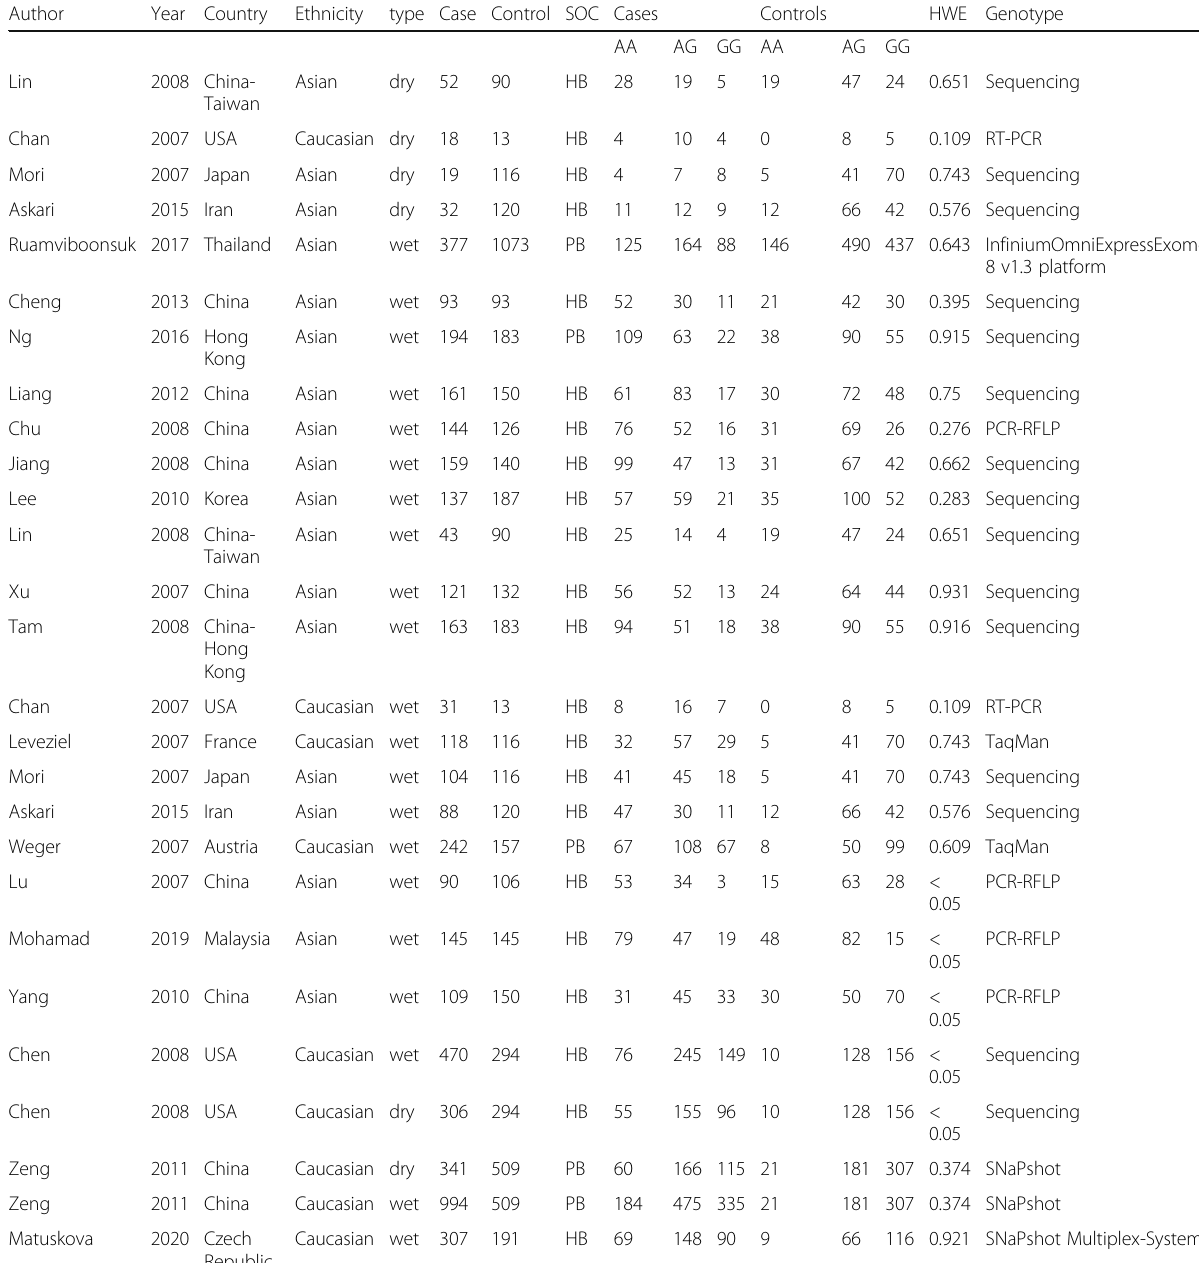
Table 2 Characteristics of included studies in HTRA1 rs11200638 polymorphism and wet/dry AMD risk,